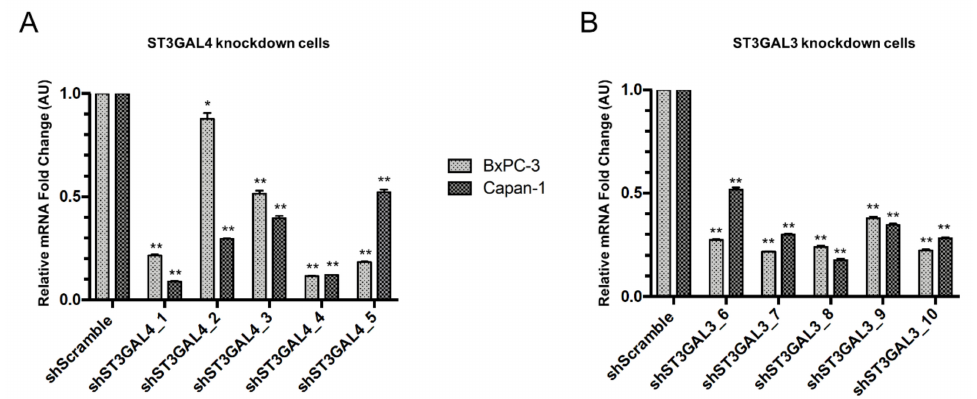
Figure 4. Relative quantification of ST3GAL3 and ST3GAL4 mRNA expression in pancreatic cells after shRNA transfection. ( A ) RT-qPCR validation of the knockdown of ST3GAL4 (shST3GAL4_1-5 cells) in Capan-1 and BxPC-3. Scramble control cells (shScramble) were generated by stable transfection with non-target scramble vector. ( B ) RT-qPCR validation of the knockdown of ST3GAL3 (shST3GAL3_6-10 cells) in Capan-1 and BxPC-3. RNA levels were normalized using TBP as a housekeeping gene. Data are expressed as mean ± SD of three independent experiments * represents p < 0.05; ** p < 0.01 (Student’s t